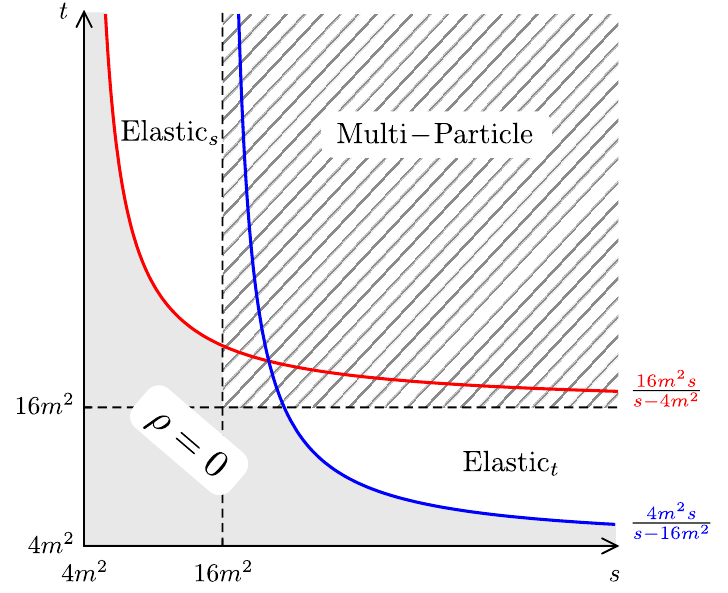
Figure 4 . The double discontinuity of the amplitude ρ ( s, t ) in the real ( s, t ) plane. In gray is the Steinmann shadow region where ρ vanishes. This region extends inside the elastic bands, { (4 m 2 < s < 16 m 2 , t ) , ( s, 4 m 2 < t < 16 m 2 ) } , and is bounded by the Landau curve t 1 ( s ) = 16 m 2 s s − 4 m 2 (in red) and its crossed curve t cross ( s ) = 4 m 2 s (in blue). These two curves extend out of the 1 s − 16 m 2 elastic bands, where there are additional multi-particle contributions. They cross at s = t = 20 m 2